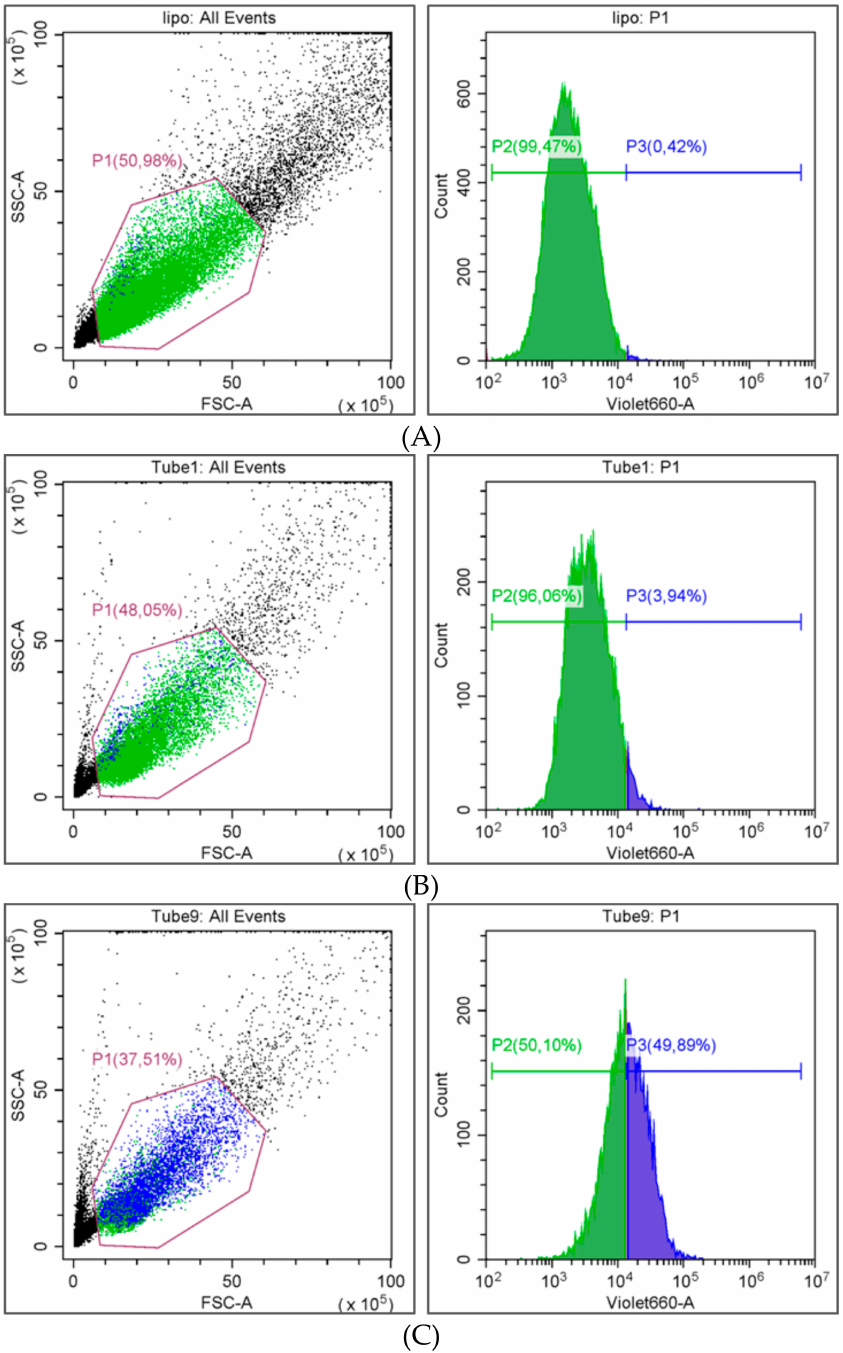
Figure 9. Flow cytometry diagrams of untreated cell control ( A ), sorafenib-loaded Resomer ® RGP d5055 ( B ), and Resomer ® RG 752H nanocomposites ( C